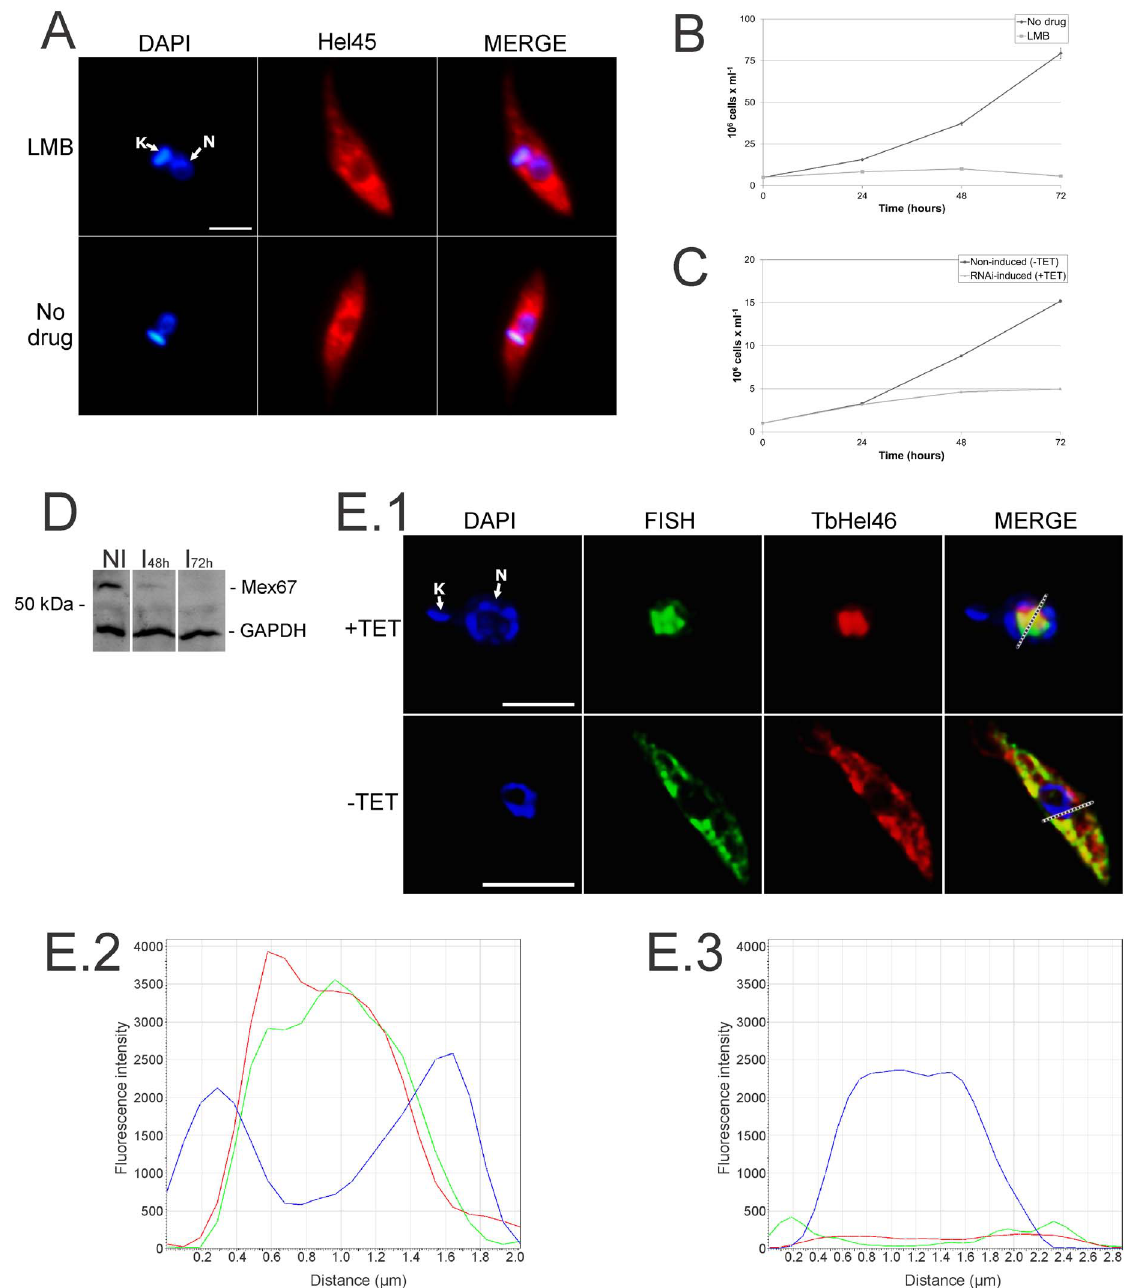
Figure 6. Localization of Hel45 after leptomycin B treatment in T.cruzi and localization of the ortholog of Hel45 (TbHel46) in T. brucei after Mex67 RNAi induction. (A) Detection of exogenous Hel45 tagged with PTP at the NT by indirect immunofluorescence with an anti- ProtA antibody. T. cruzi parasites were treated with 500 ng/ml leptomycin B (LMB) for 24 hours or were untreated (control). (B) Growth curve of T. cruzi parasites after treatment with 500 ng/ml leptomycin B (LMB). (C) Growth curve of T. brucei parasites after the induction of RNAi against Mex67 with 2 m g/ml tetracycline (RNAi-induced). (B) and (C) represent graphics of a biological replica which the density of cells in the culture was determined by counting in triplicate with a particle counter (Beckman Coulter). (D) Western-blot analysis of total protein extracts from parasites 48 (I 48 h ) or 72 (I 72 h ) hours after the induction of Mex67 RNAi. Non-induced (NI) parasites are shown as a control. The assay was carried out with anti- Mex67 antibodies. Anti-GAPDH antibodies were used as loading control. (E.1) Cellular localization of mRNA by fluorescence in situ hybridization (FISH) with a digoxigenin-conjugated oligo(dT) probe and localization of TbHel46 by indirect immunofluorescence Cells were fixed 48 hours after the induction of Mex67 RNAi ( + TET). Images were processed by deconvolution software Leica AF6000. DAPI=DNA stained with DAPI. Hel45= localization of tagged Hel45. TbHel46= endogenous TbHel46 localized with anti-Hel45 antibodies. MERGE=merged images for DAPI staining and Hel45 localization (A) or DAPI staining, FISH and TbHel46 localization (E.1). N=nucleus. K=kinetoplast. (E.2 and E.3) Graphs show the quantification of fluorescence intensity of DAPI (blue), FISH (green), and TbHel46 (red) labelling that was detected across the dotted line in E.1. Fluorescence intensity was plotted in the y-axis for Mex67 RNAi-induced parasites ( + TET, Figure E.2) and non-induced parasites ( 2 TET, Figure E.3).